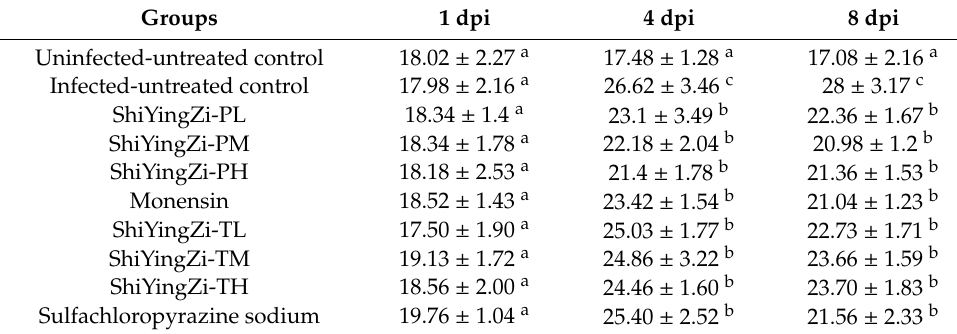
Table 10. The creatinine content ( µ mol / L).